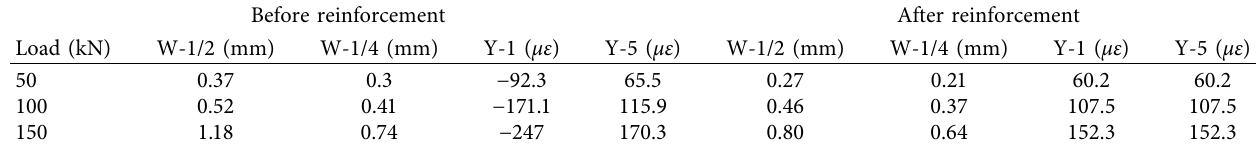
Table 9: The comparison of strain and deflection (before and after carbon-fiber reinforcement) under different load. Before reinforcement After reinforcement